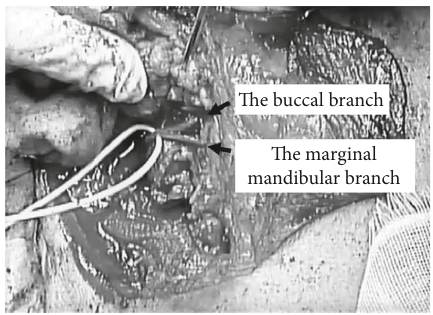
Figure 3: Intraoperative view of the facial nerve. The buccal branch and marginal mandibular branch can be seen to be compressed by the tumor.